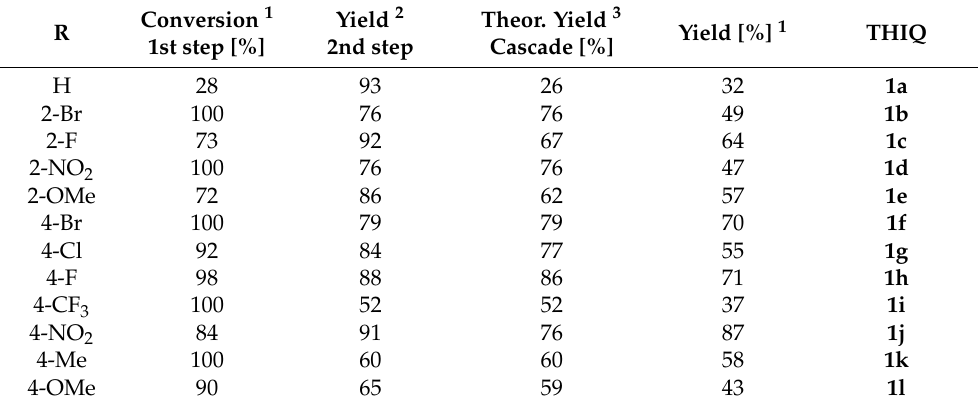
Table 5. Obtained and theoretical yields of chemoenzymatic one-pot